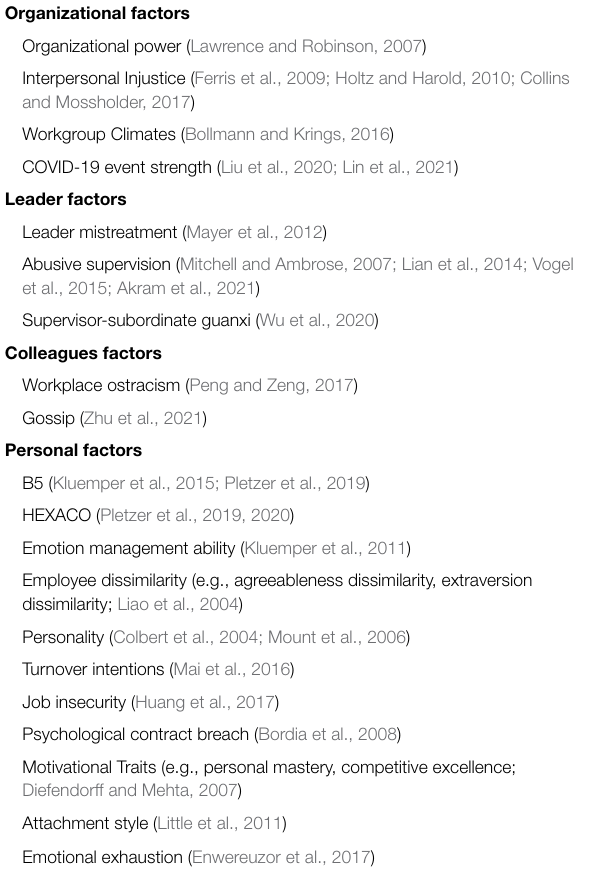
TABLE 1 | Predictors of workplace deviance